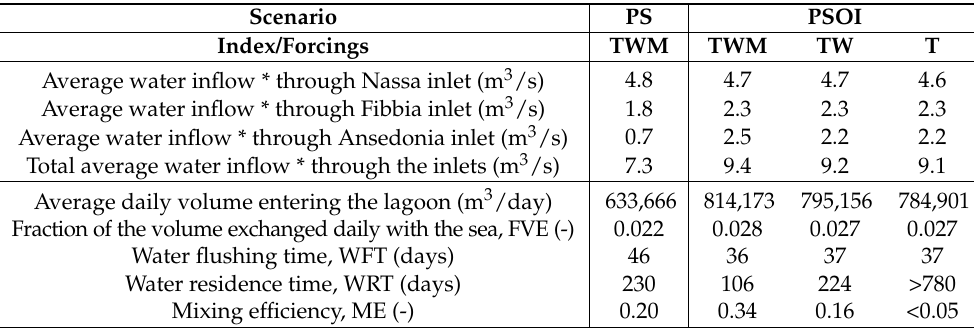
Table 3. Average water inflow through the inlets and indexes of water transport timescale in the present scenario, with (PS) and without (PSOI) gates and grids obstacles in the inlets, under different combinations of forcing mechanisms: astronomical tide, wind, and meteorological tide (TWM); astronomical tide and wind (TW); and astronomical tide only (T). Scenario PS PSOI Index/Forcings TWM TWM TW T Average water inflow * through Nassa inlet (m 3 /s) 4.8 4.7 4.7 4.6 Average water inflow * through Fibbia inlet (m 3 /s) 1.8 2.3 2.3 2.3 Average water inflow * through Ansedonia inlet (m 3 /s) 0.7 2.5 2.2 2.2 Total average water inflow * through the inlets (m 3 /s) 7.3 9.4 9.2 9.1 Average daily volume entering the lagoon (m 3 /day) 633,666 814,173 795,156 784,901 0.022 0.028 0.027 0.027 Water flushing time, WFT (days) 46 36 37 37 Water residence time, WRT (days) 230 106 224 >780 Mixing efficiency, ME (-) 0.20 0.34 0.16